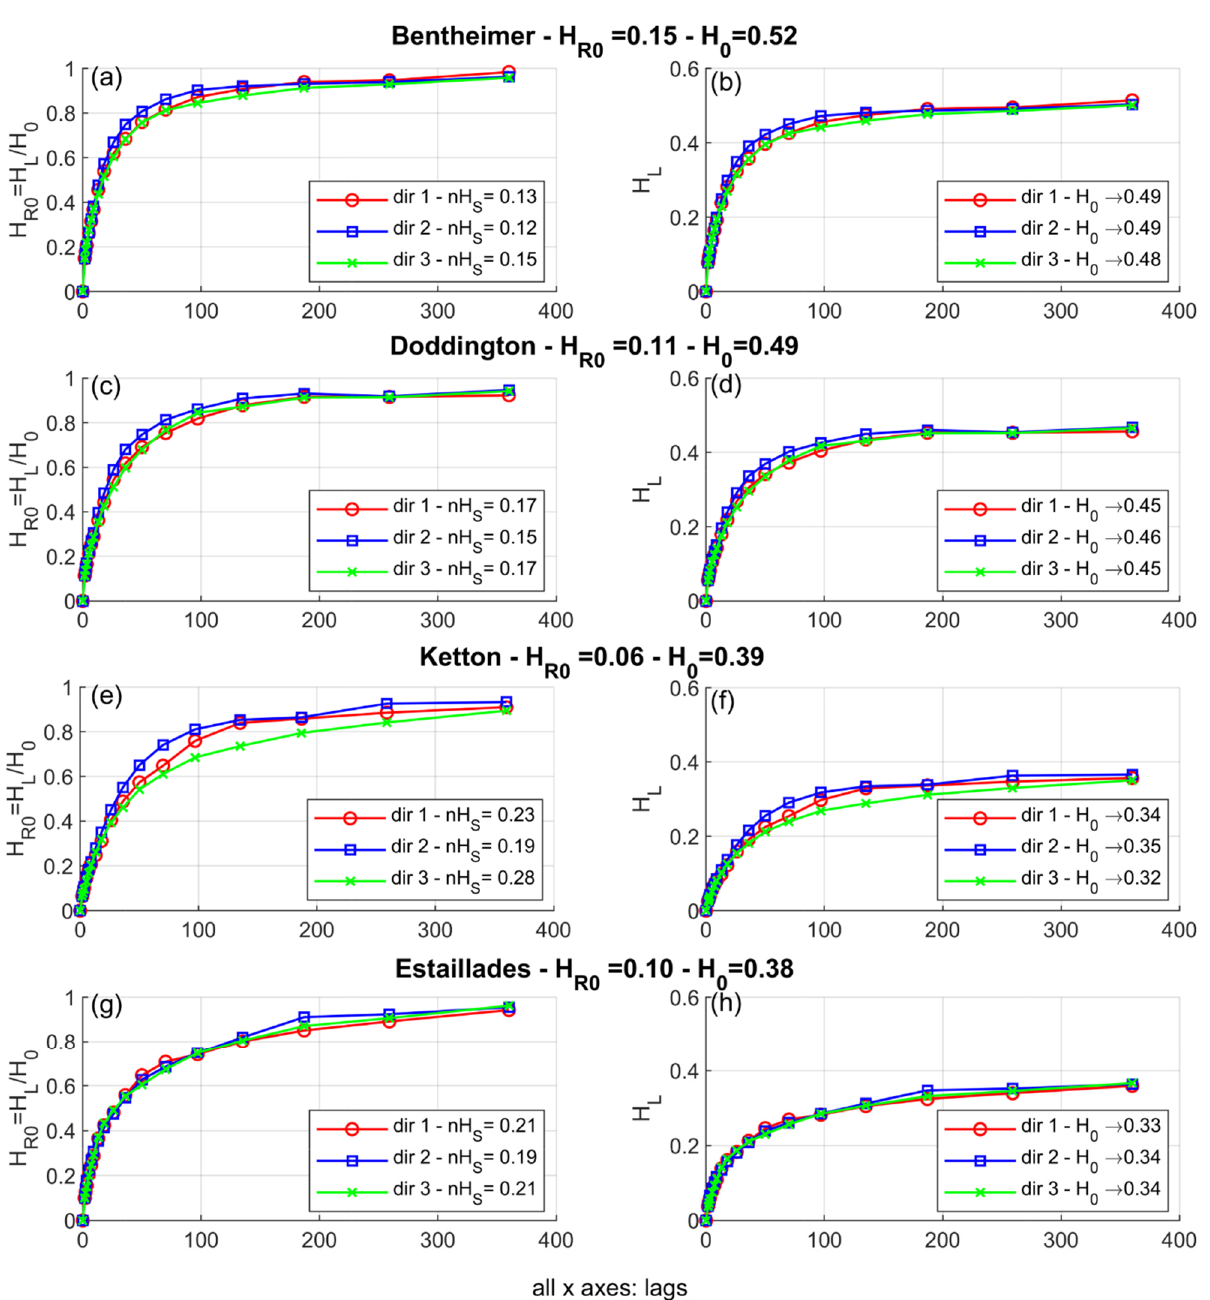
Figure 9. Entrograms and corresponding statistics calculated using GEOENT for each of the four analysed digitalised rock samples . ( a , b ) Normalized and not ‐ normalized entrograms of the Ben ‐ theimer rock samples, respectively; ( c , d ) Normalized and not ‐ normalized entrograms of the Dod ‐ dington rock samples, respectively; ( e , f ) Normalized and not ‐ normalized entrograms of the Ketton rock samples, respectively; ( g , h ) Normalized and not ‐ normalized entrograms of the Estaillades rock samples, respectively.